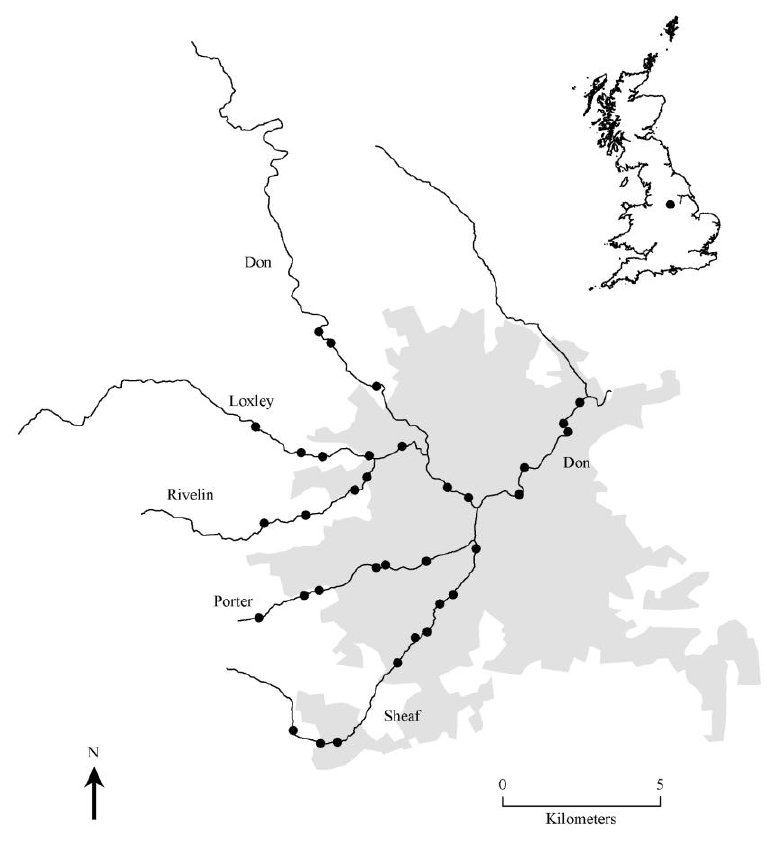
Figure 1. The urban area of Sheffield, United Kingdom (shaded), showing the major rivers running through the city (solid lines) and study sites (filled circles). The inset shows the location of Sheffield in